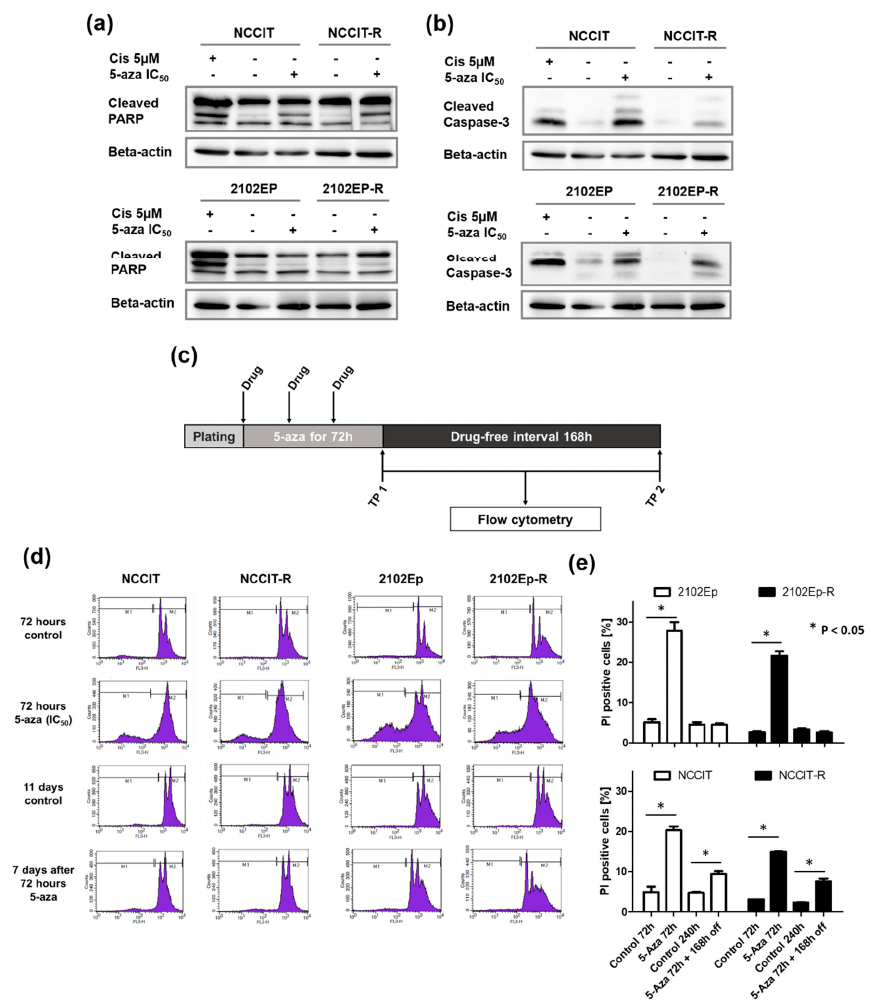
Figure 3. 5 ‐ aza treatment exerts sustained apoptotic impact on EC cell lines. ( a ) PARP1 cleavage remains high in NCCIT and NCCIT ‐ R cells, while 2102EP and 2102EP ‐ R cells seem to lose PARP1 degradation over time. ( b ) Caspase ‐ 3 cleavage continues in all 4 cell lines, but to a lesser extent in both cisplatin ‐ resistant isogenic sublines. Interestingly, after a 168 h ‐ break after 5 ‐ aza exposure, 5 μ M cisplatin seemed to induce delayed apoptosis to the highest degree. ( c ) Schematic experimental design of cell cycle analyses (TP, time point). ( d ) Flow cytometric analysis of PI ‐ positive apoptotic cells among all tested cell lines. ( e ) Evaluation of the experiments conducted in D. Even a week after the end of 5 ‐ aza treatment, TP53 ‐ mutant NCCIT and NCCIT ‐ R cells underwent apoptosis more frequently when compared to untreated control cells. Shown are mean ± standard deviation (SD) of experiments, which were repeated three times with similar results. 2.3. Nanomolar Concentration of 5 ‐ Aza Overcomes Cisplatin ‐ Resistance in EC cells The levels of cisplatin resistance in the individual cell lines have been determined previously [15]. Here, we sought to define whether 5 ‐ aza would sensitize cisplatin ‐ resistant cells to cisplatin. Therefore, the cells were first exposed to 5 ‐ aza for 72 h at either a low concentration of 10 nM or the